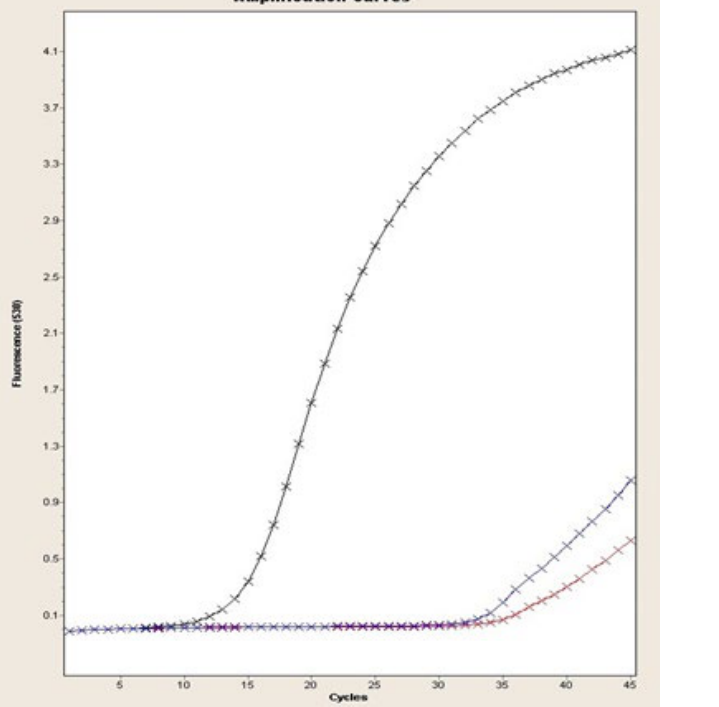
Fig. 6. 16S gene amplification curve, FEND, ITUDI of Bacillus megaterium versus Botrytis sp., at day 5 (LightCycler®,